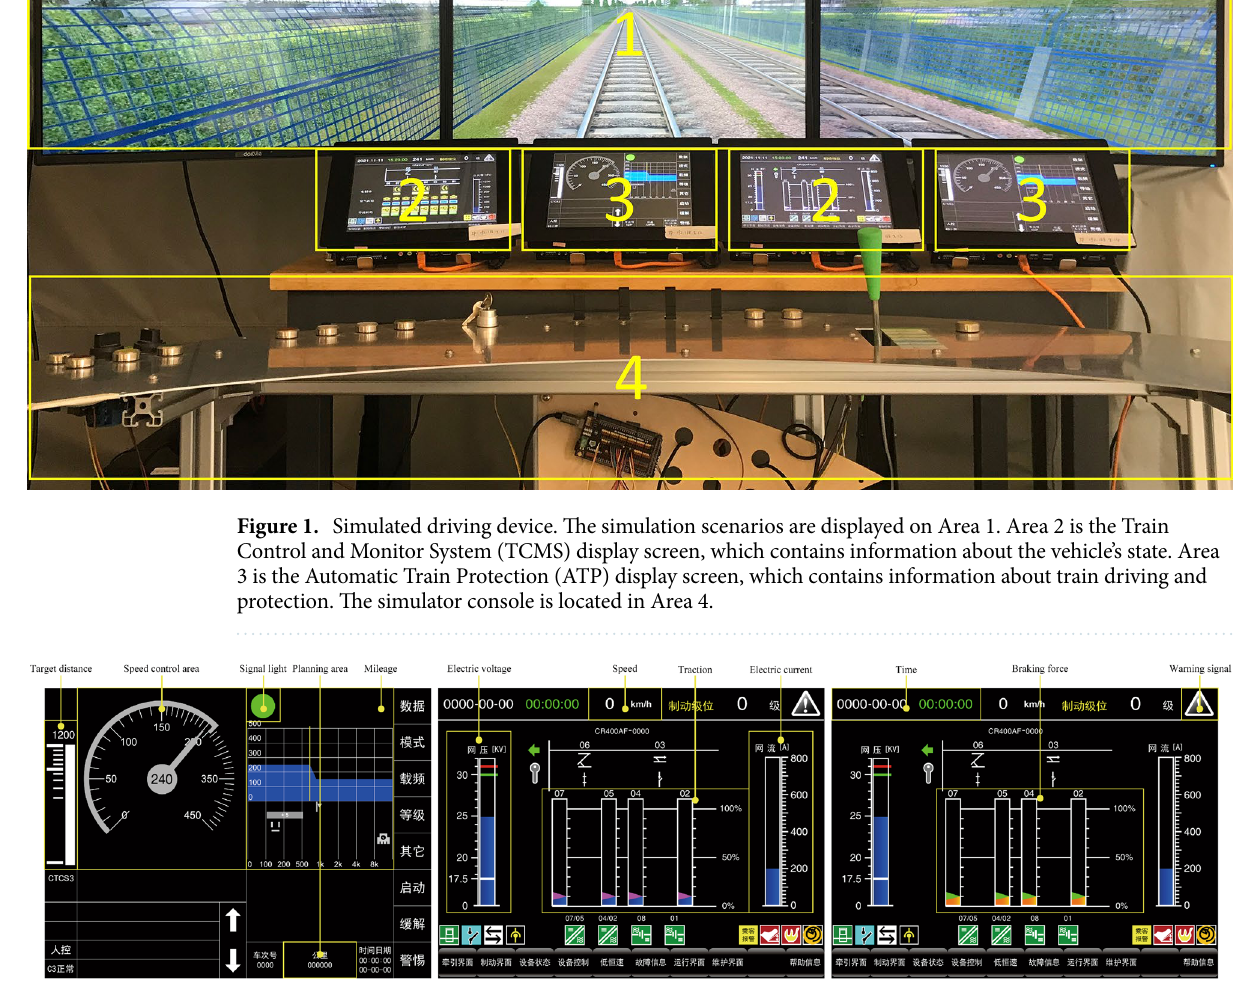
Figure 2. An example of the ATP display (left), the TCMS display of traction status (middle) and the TCMS display of braking status